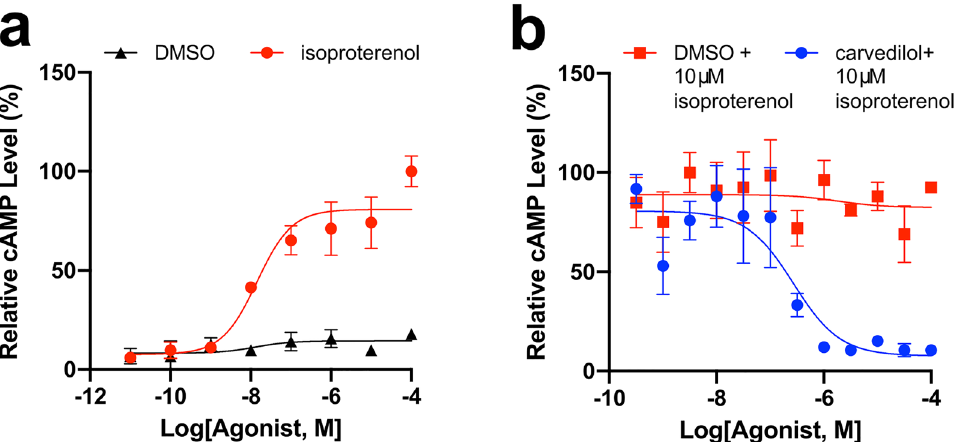
Figure 5. Carvedilol treatment might directly act on rods cells. To determine the extent to which carvedilol act directly on rods, we conducted a GloSensor cAMP assay with human Y79 cells. ( a ) Representative dose– response curves of GloSensor-transfected Y79 cells treated with half-log concentrations of isoproterenol (red trace; N = 4) or percentage-matched DMSO (black trace; N = 4). These plots were normalized to the maximum average luminescent level recorded per experiment. Error bars show ± 1 s.e.m. Isoproterenol was capable of increasing cAMP signaling through β-adrenergic receptor binding with an pEC50 of 7.49 ± 1.07. ( b ) Representative dose–response curves of GloSensor-transfected Y79 cells pretreated with half-log doses of carvedilol (blue trace; N = 4) or percentage-matched DMSO (red trace; N = 4). Cells were then challenged with a 10 μM isoproterenol that could induce maximal cAMP response, as shown in ( a ). Carvedilol pretreatment was capable of preventing isoproterenol-mediated cAMP increases with an pIC50 of 6.51 ±